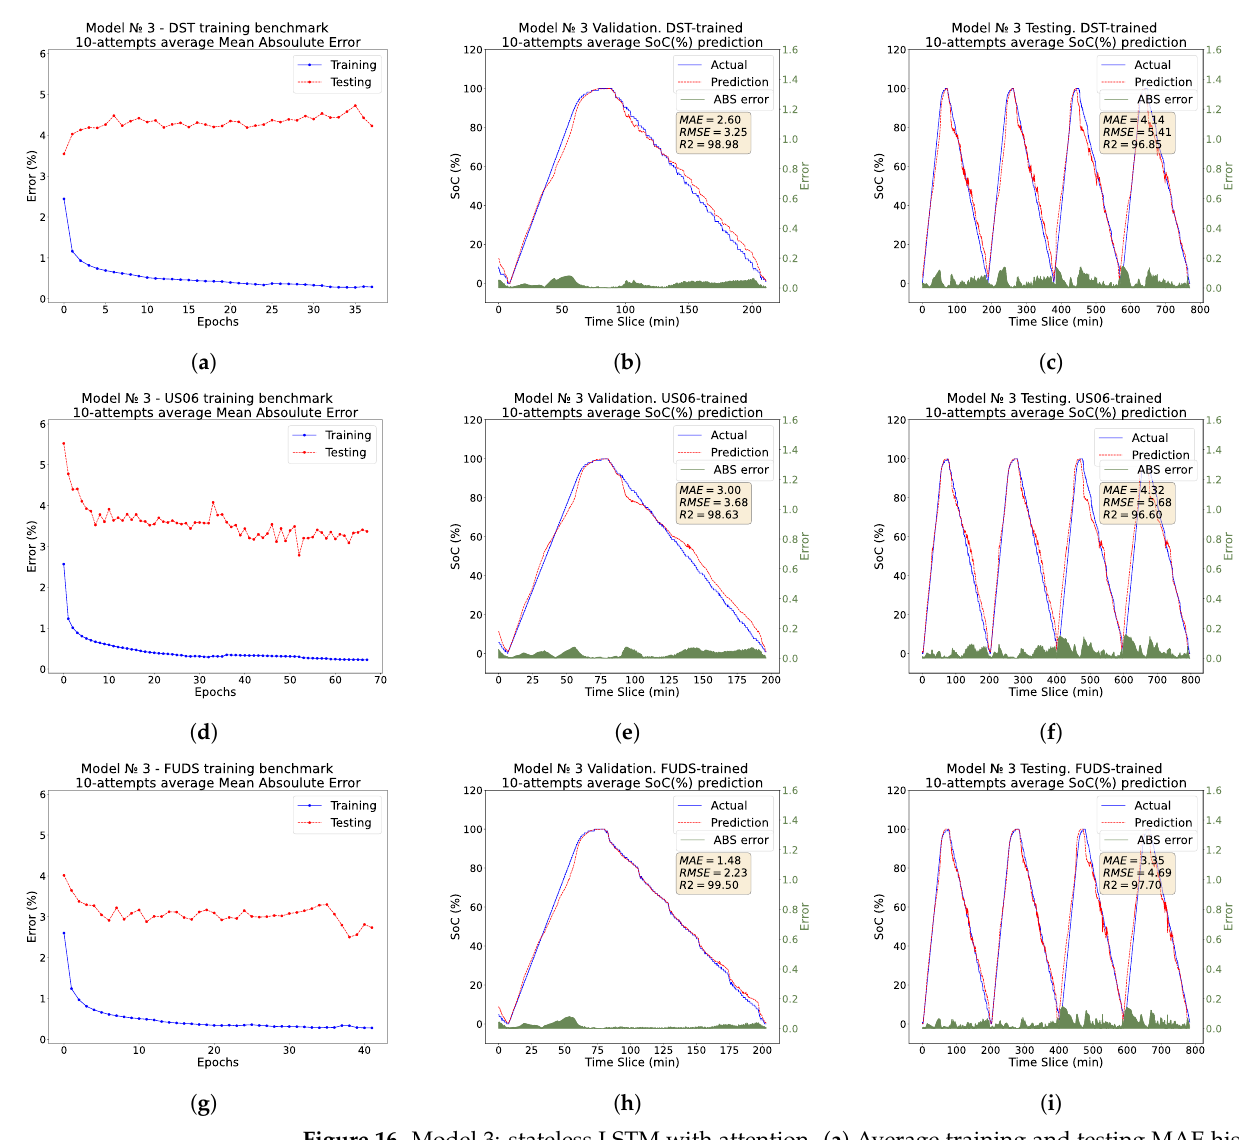
Figure 16. Model 3: stateless LSTM with attention. ( a ) Average training and testing MAE history; average of 10 attempts. ( b ) Validation on a single cycle of SoC estimation; average of 10 attempts at 25 °C. ( c ) Testing on two cycles of US06 and FUDS profiles; average of 10 attempts. ( d ) Average training and testing MAE history; average of 10 attempts. ( e ) Validation on a single cycle of SoC estimation; average of 10 attempts at 25 °C. ( f ) Testing on two cycles of DST and FUDS profiles; average of 10 attempts. ( g ) Average training and testing MAE history; average of 10 attempts. ( h ) Validation on a single cycle of SoC estimation; average of 10 attempts at 25 °C. ( i ) Testing on two cycles of DST and US06 profiles; average of 10